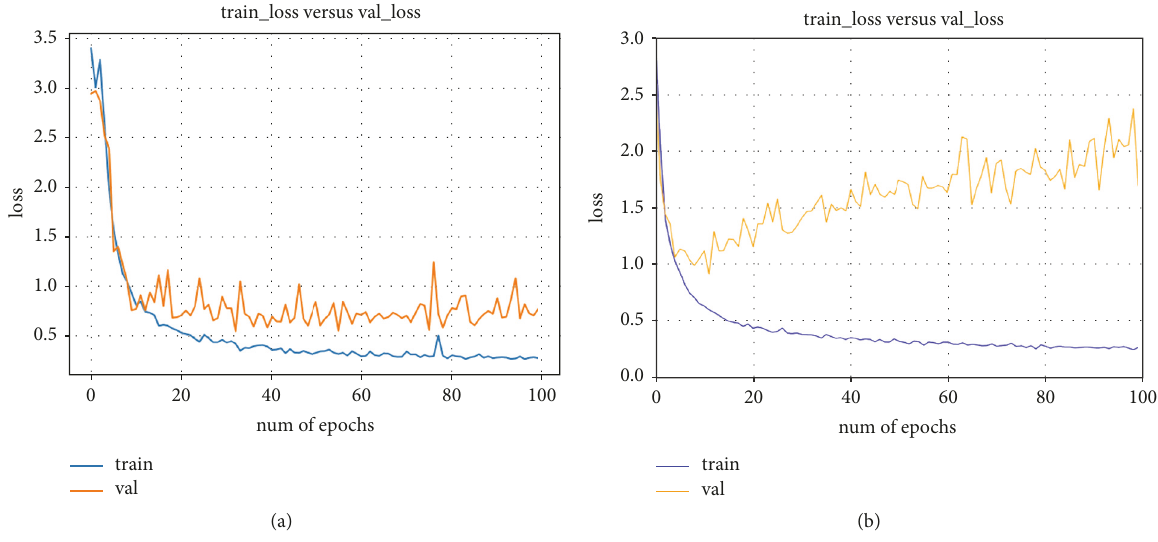
Figure 6: Training loss and validation loss (a) for offline data and (b) for online data. Table 3: Performance comparison of CNN with different convolutional filter